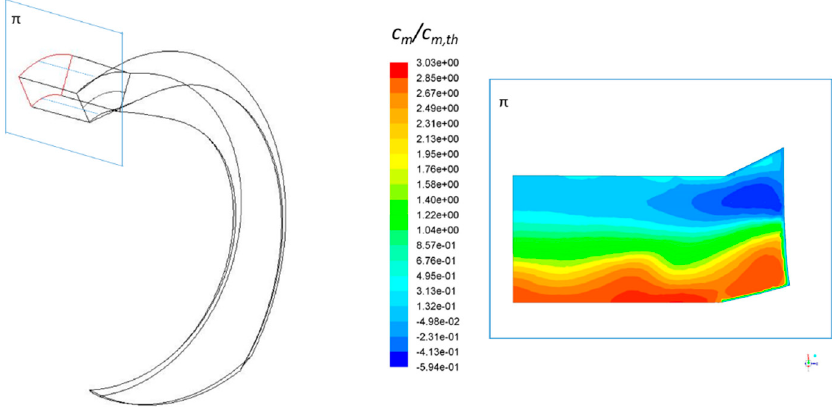
Figure 11. Contours of the meridional velocity over the theoretical value on a meridional plane, across the vane outlet and the initial part of the draft tube.